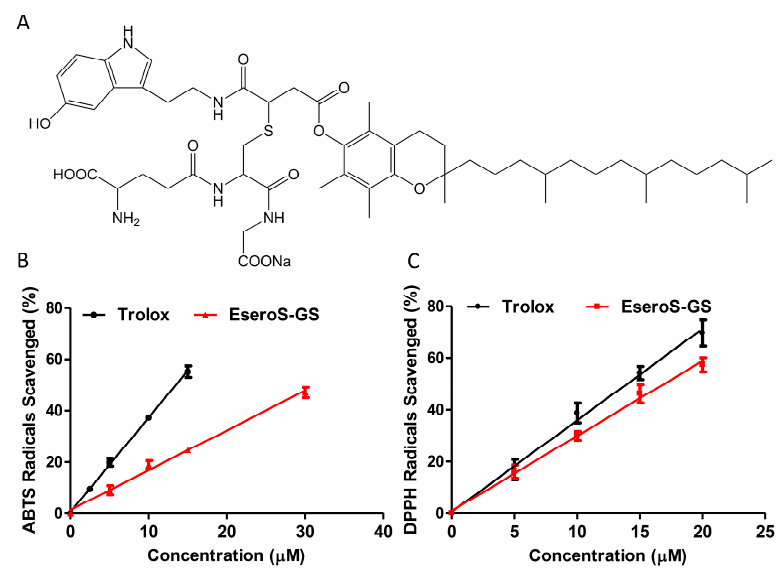
Figure 1. Scavenging effects of ESeroS-GS and Trolox on free radicals. ( A ) structure of ESeroS-GS; ( B ) scavenging effects of ESeroS-GS and Trolox on ABTS •+ free radicals; ( C ) scavenging effects of ESeroS-GS and Trolox on DPPH free radicals.